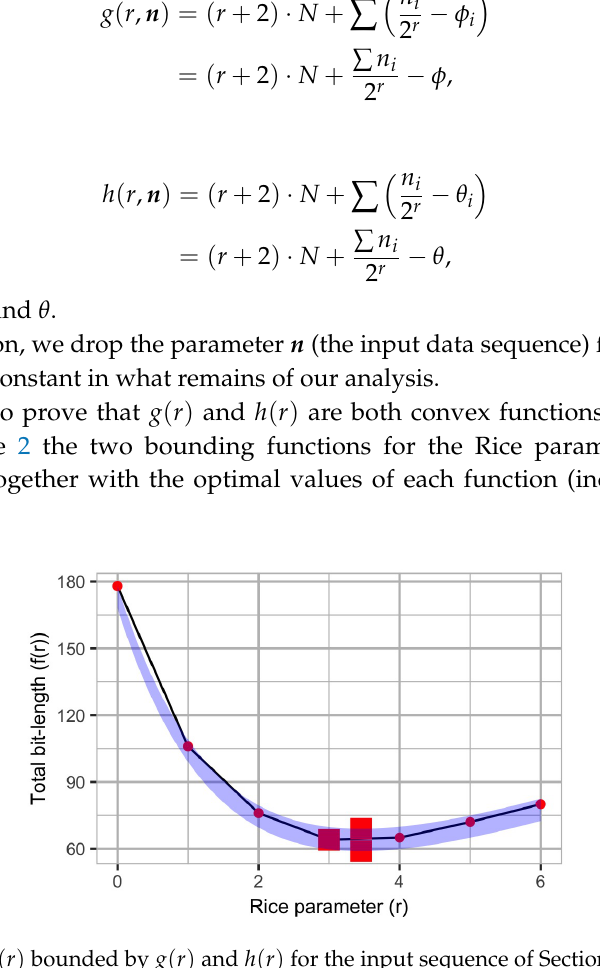
Figure 2. Function f ( r ) bounded by g ( r ) and h ( r ) for the input sequence of Section 1.1. The minimum value of each function is marked with a squared red dot. The total bit-length function f ( r ) is only defined for integer values of r . A continuous line was added between the points to improve